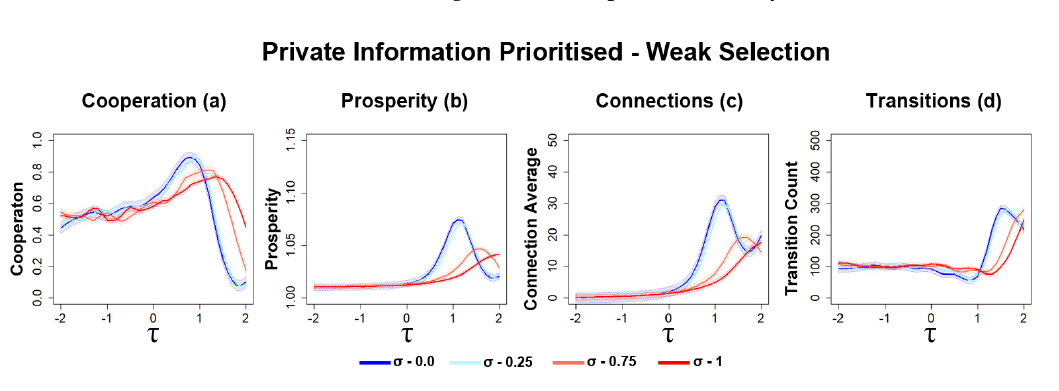
Figure 8. Limited public information leads to a limited decrease in cooperation. The plots visualise and compare the metrics of cooperation, prosperity, average connectivity and number of transitions for differing levels of opinion diversity. Data obtained by running the model for 10 8 steps with p = 0.25 and q = 0.75 and a δ setting of 0.001. τ represents the decision threshold. σ represents opinion diversity. Shading represents level of standard error calculated for each dataset. Data interpolated utilising RStudio [22]. Plots produced via RStudio utilising code found in Appendix A.